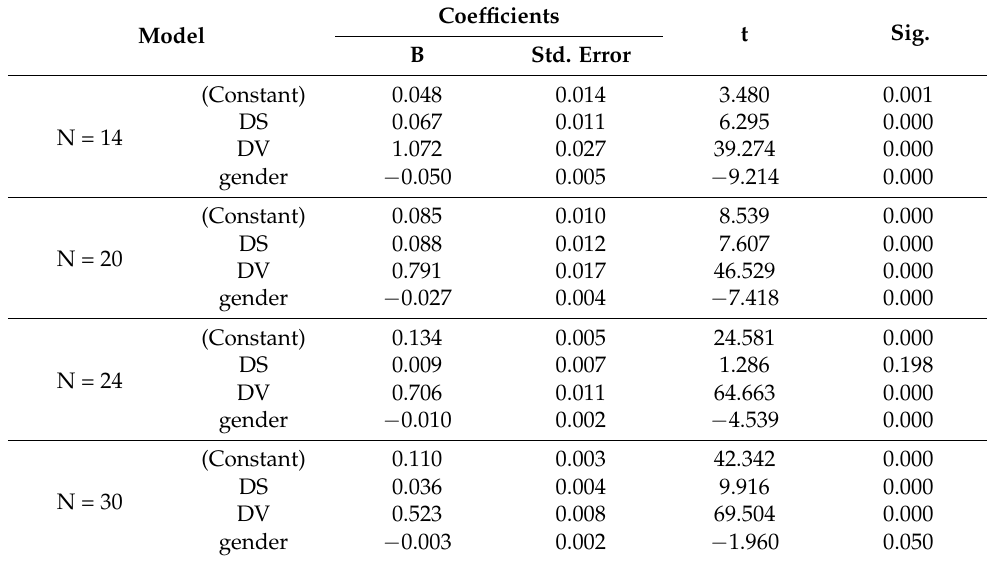
Table 2. Coefficients in the multiple regression models for